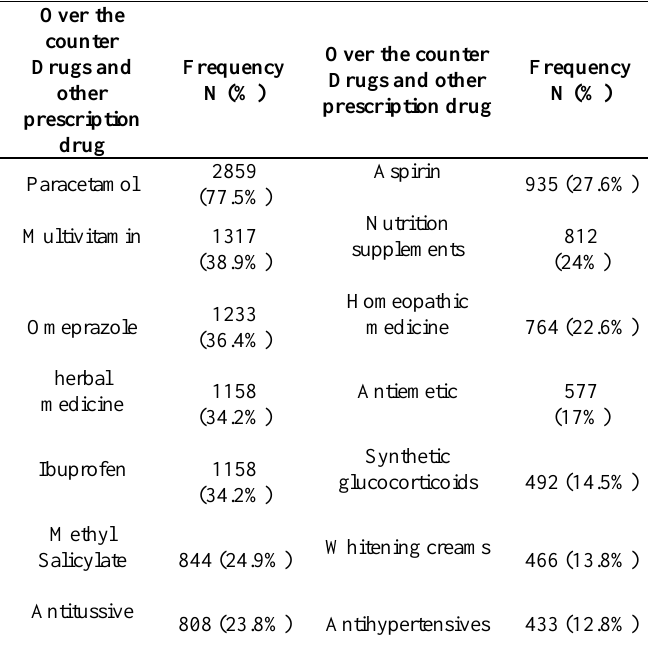
Table 4: OTC drugs and OPDEA commonly used as self-